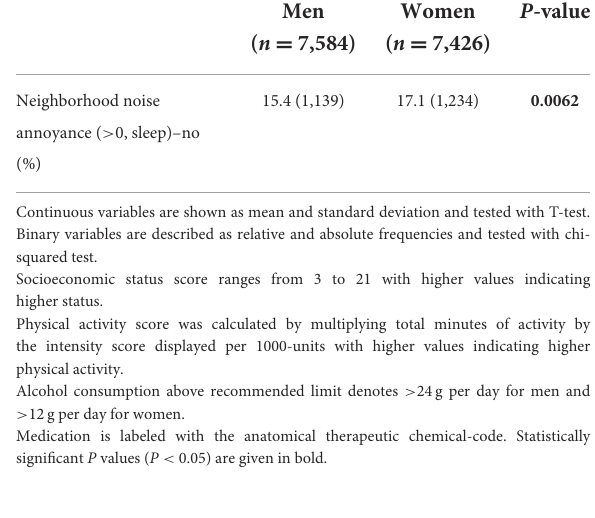
TABLE 1 Baseline characteristics of the study sample stratified by sex ( N =